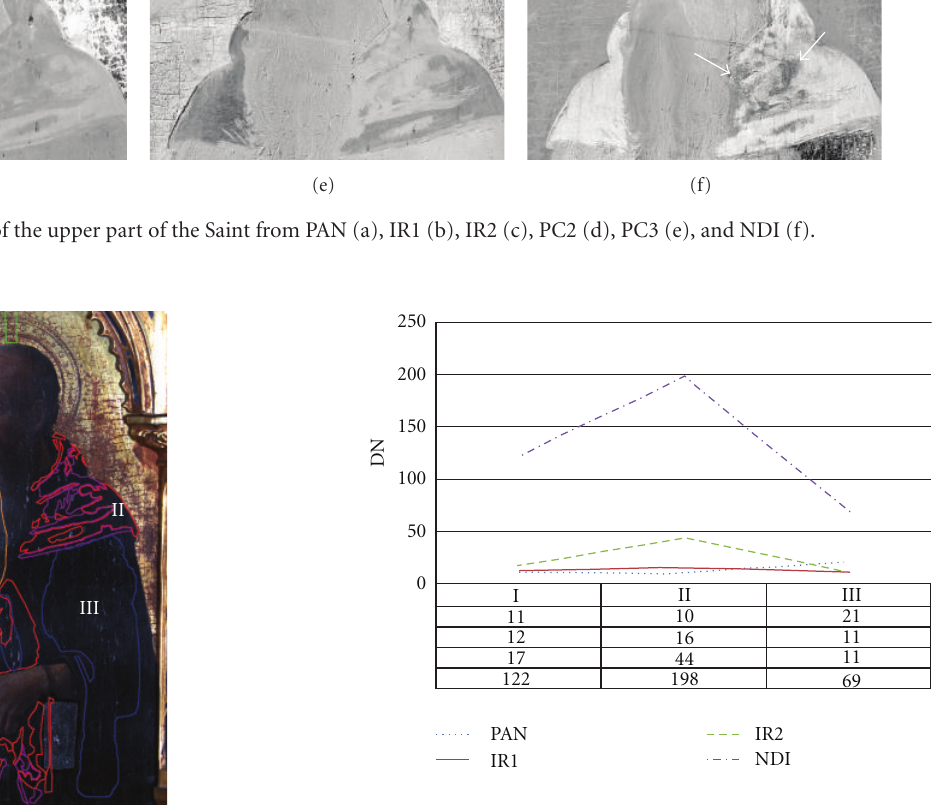
Figure 9: DN average of patterns I, II, and III measured from PAN, IR1, IR2, and